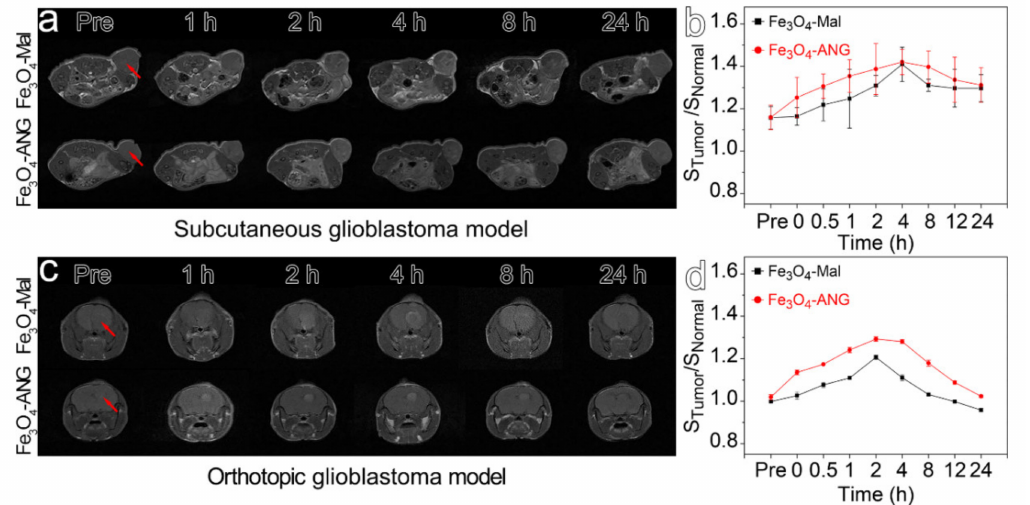
Figure 5. ( a ) MRI of the subcutaneous glioblastoma model within 24 h after injection of Fe 3 O 4 -Mal or Fe 3 O 4 -ANG NPs. ( b ) Tumor signal trends for the subcutaneous glioblastoma model after injection of Fe 3 O 4 -Mal or Fe 3 O 4 -ANG NPs. ( c ) MRI of the orthotopic glioblastoma model within 24 h after injection of Fe 3 O 4 -Mal or Fe 3 O 4 -ANG NPs. ( d ) Tumor signal trends for the orthotopic glioblastoma model after injection of Fe 3 O 4 -Mal or Fe 3 O 4 -ANG NPs.